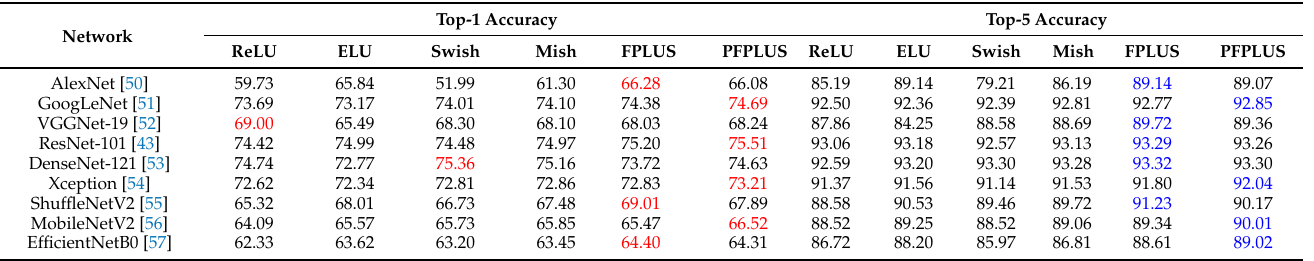
Table 7. Top-1 and top-5 accuracy rates (%) on validation set of CIFAR-100 for multiple networks with different activation